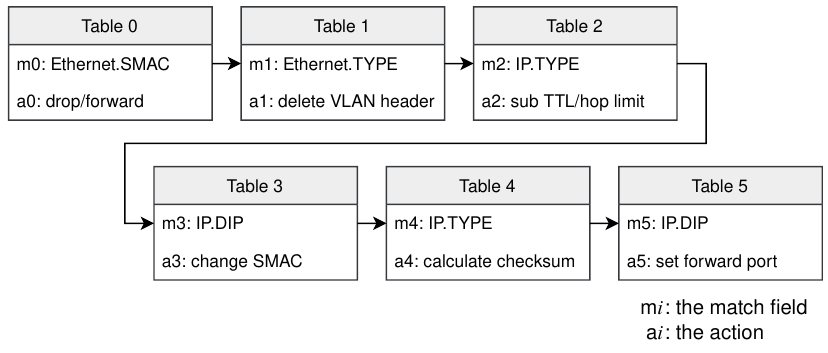
Figure 8. The match-action tables of the L2/L3